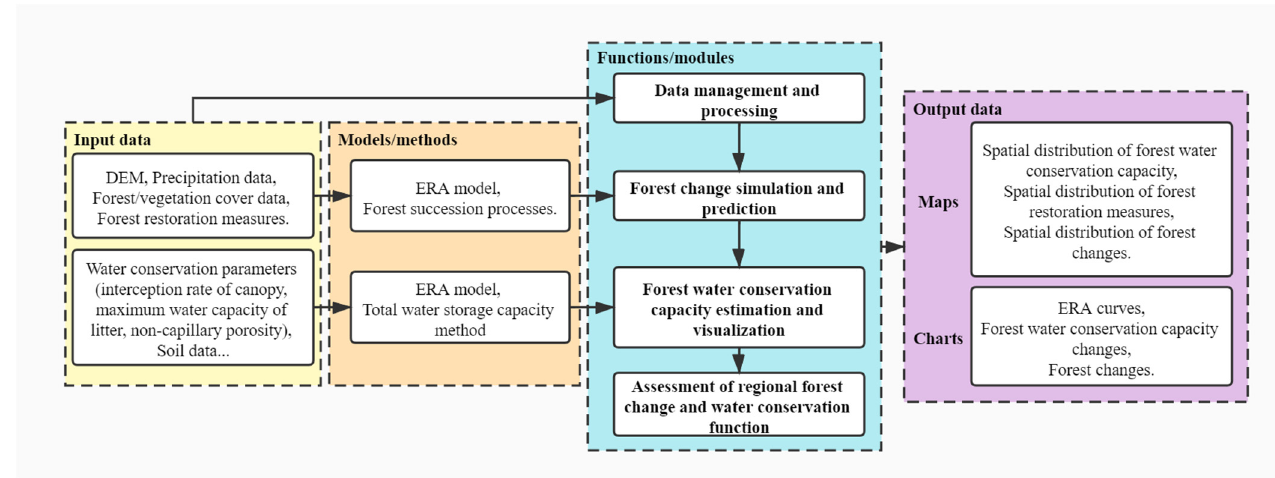
Figure 1. The framework of evaluation processes.